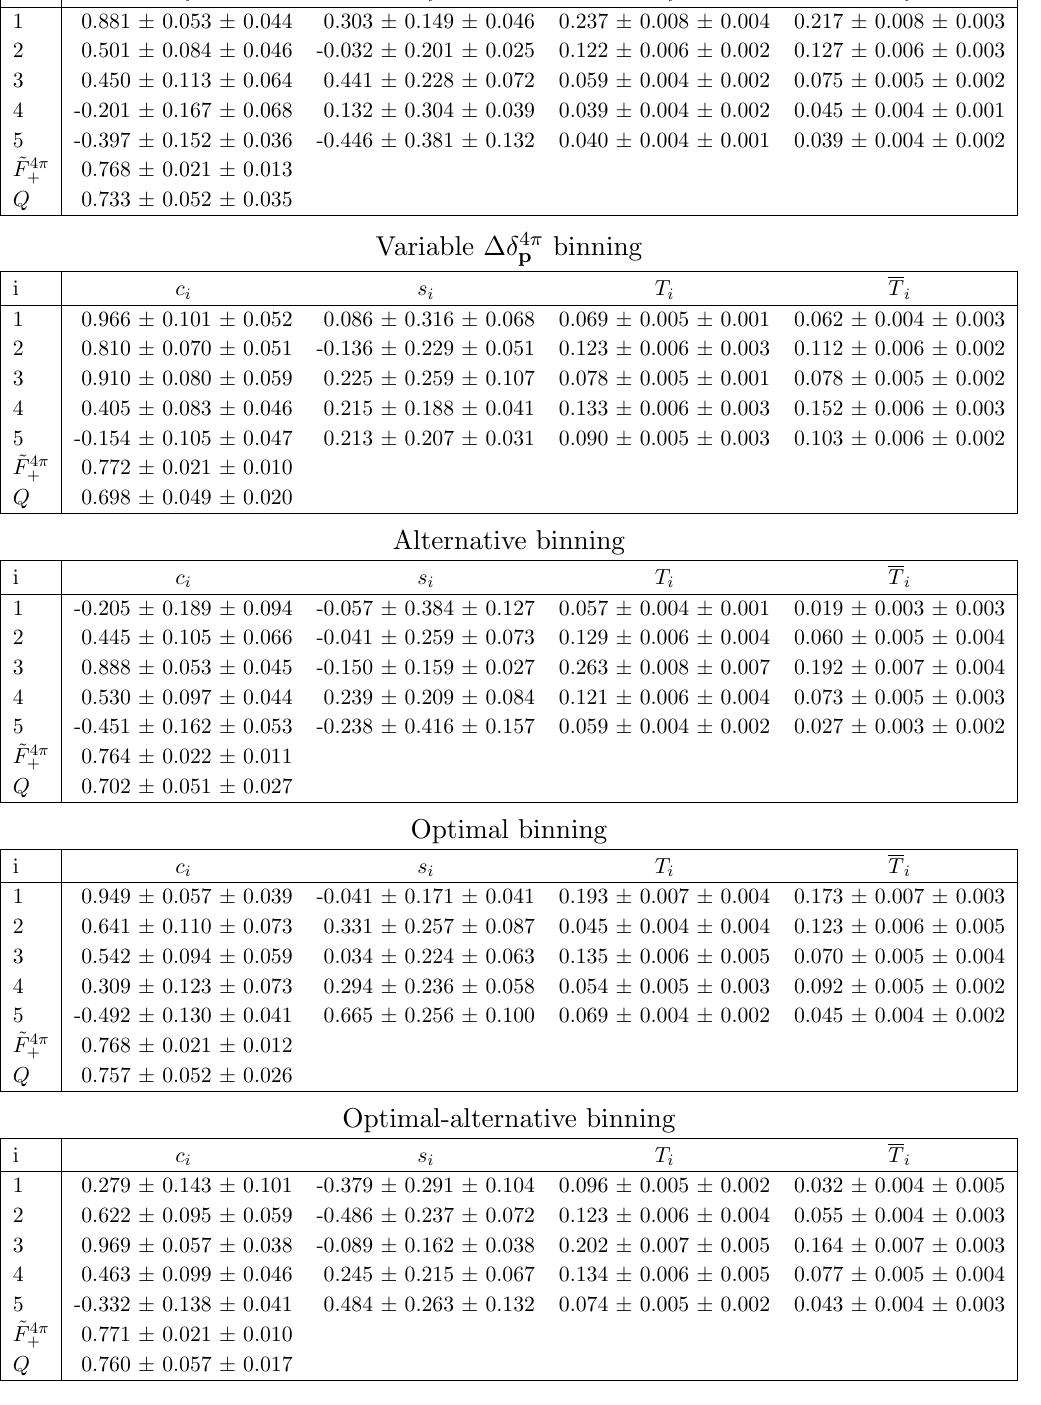
Table 7 . The hadronic parameters measured for each of the 4 (cid:25) (cid:6) binning schemes discussed in sec- tion 4 where N = 5. The (cid:12)rst uncertainty given is statistical, and the second systematic. Also given is the CP-even fraction, ~ F 4 (cid:25) , and the Q value, de(cid:12)ned in section 4; the uncertainties on these param- + eters are propagated from the statistical and systematic uncertainties on the hadronic parameters.